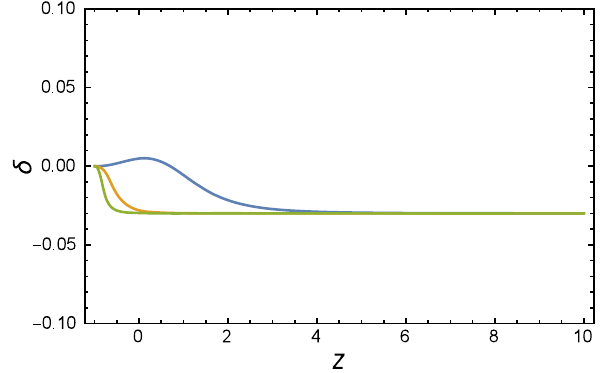
(cid:6) Fig. 3 δ = λ x here represents the strength of the interactions, the x blue,orangeandgreencurvecorrespondtothecasewith (λ, x 0 ,(cid:2) m 0 ) = ( 0 . 01 , 0 . 6 , 0 . 27 ),( 0 . 01 , 10 , 0 . 27 ),( 0 . 01 , 100 , 0 . 27 ) , respectively